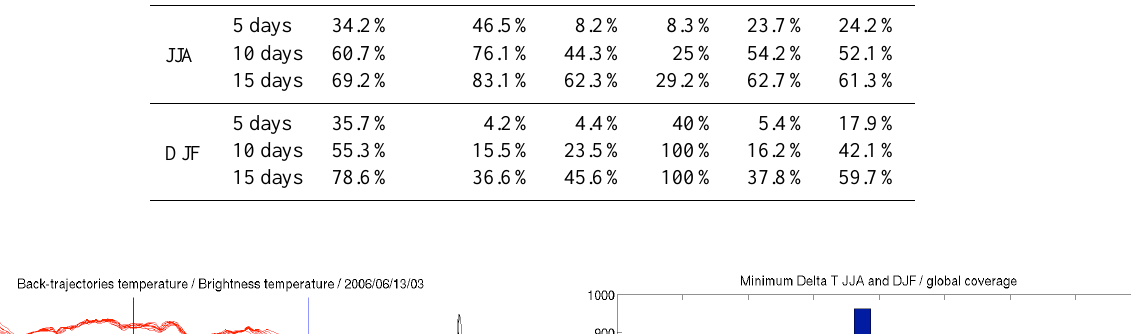
Fig. 15. Brightness temperatures (K) along 10 back-trajectories initialized on 13 June 2006 near 03:15UTC. SVC detections near 27 ◦ E are marked by crosses. This composite map was produced by selecting for each back-trajectory point the MERG map closest in time, and extracting brightness temperatures 20km around the point. Table 5. Percentage of C1 SVC for which at least one back-trajectory cross a convective system 5, 10 or 15 days before SVC detection in JJA and DJF. Numbers above the AMA are unreliable given the very small number of SVC observed there. Africa